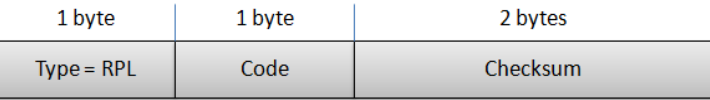
Figure 10. ICMPv6 header for RPL control messages.